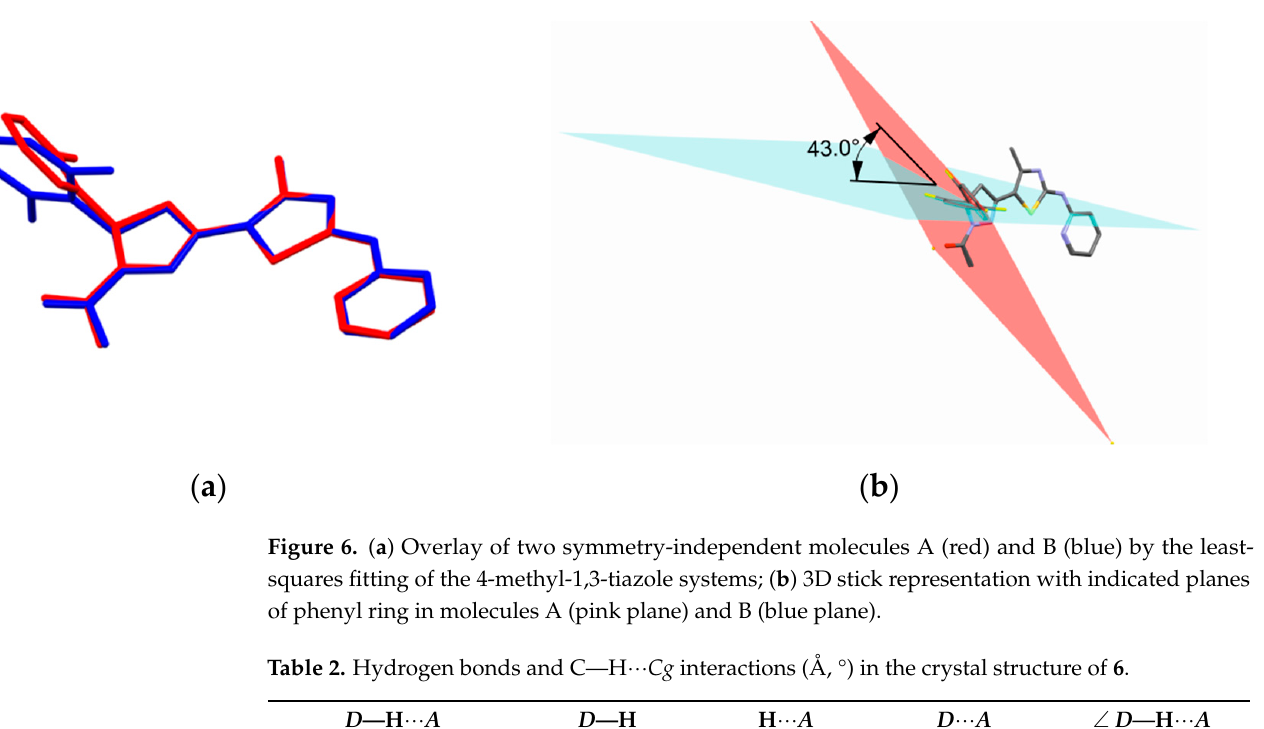
Figure 5. ORTEP view of the two symmetry-independent molecules of 6 , showing the atomic la- beling scheme. Non-H atoms are drawn as displacement ellipsoids at the 30% probability level. H atoms are drawn as spheres of arbitrary radii.